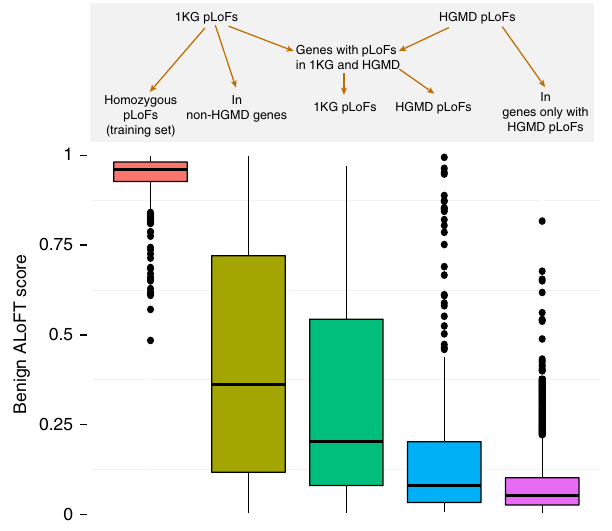
Fig. 8 ALoFT classi fi cation of 1000 Genomes and HGMD variants. Benign scores for premature stop variants in 1KG and HGMD. For this plot, we randomly selected one variant per gene. The “ Benign pLoFs ” set includes homozygous premature stop variants discovered in 1KG. The third ( dark green ) box plot pertains to premature stop variants in healthy 1KG individuals occurring in disease-causing genes obtained from HGMD. The fourth ( blue ) box plot pertains to pLoF variants in the subset of HGMD genes where 1KG pLoFs are also seen. “ 1KG pLoFs in non-HGMD genes ” include 1KG variants not in HGMD genes, i.e., non-disease genes. “ In genes only with HGMD pLoFs ” includes HGMD variants in only those disease genes where 1KG pLoFs are not seen. In the box plots , the center line represents the median value of the data, the box goes from the fi rst quartile to the third quartile. The lower whisker goes from Q1 to the smallest non- outlier in the data set, and the upper whisker goes from Q3 to the largest non-outlier in the data set. Outliers are indicated by the plotted To account for gene conservation, we calculated synonymous and non-synonymous SNP density based on variation data from 1KG, average GERP scores of synonymous and non-synonymous SNPs, the percentage of synonymous and non-synonymous SNPs in GERP-constrained elements, the percentage of coding transcript overlapping with constrained GERP elements, and average heterozygosity for synonymous and non-synonymous SNPs in 1KG. Gene centrality scores were obtained for various networks from Khurana et al. 64